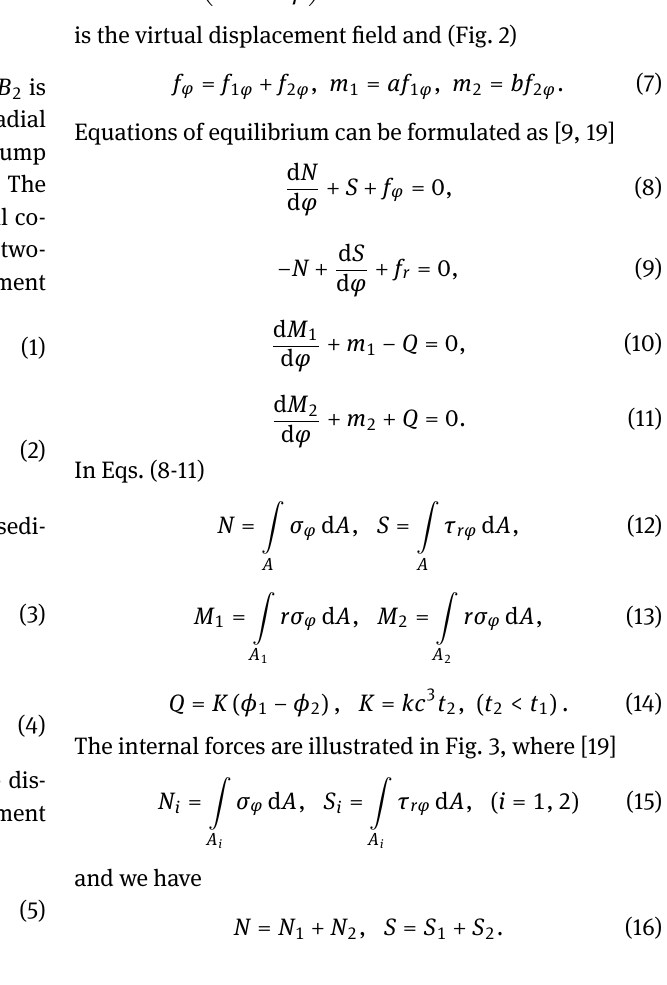
Figure 1: Two-layer curved beam.